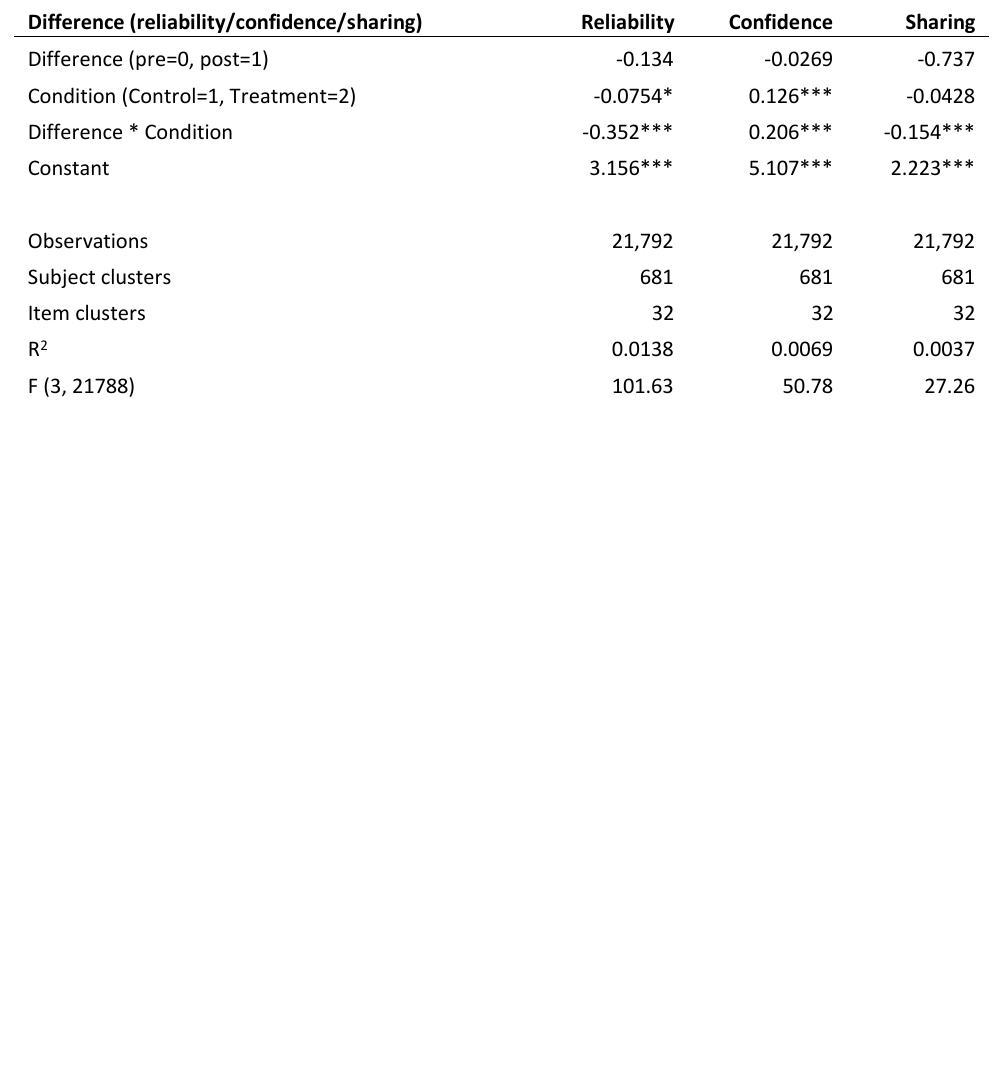
Appendix: Table S5: Linear regression model at the rating level following Pennycook et al.